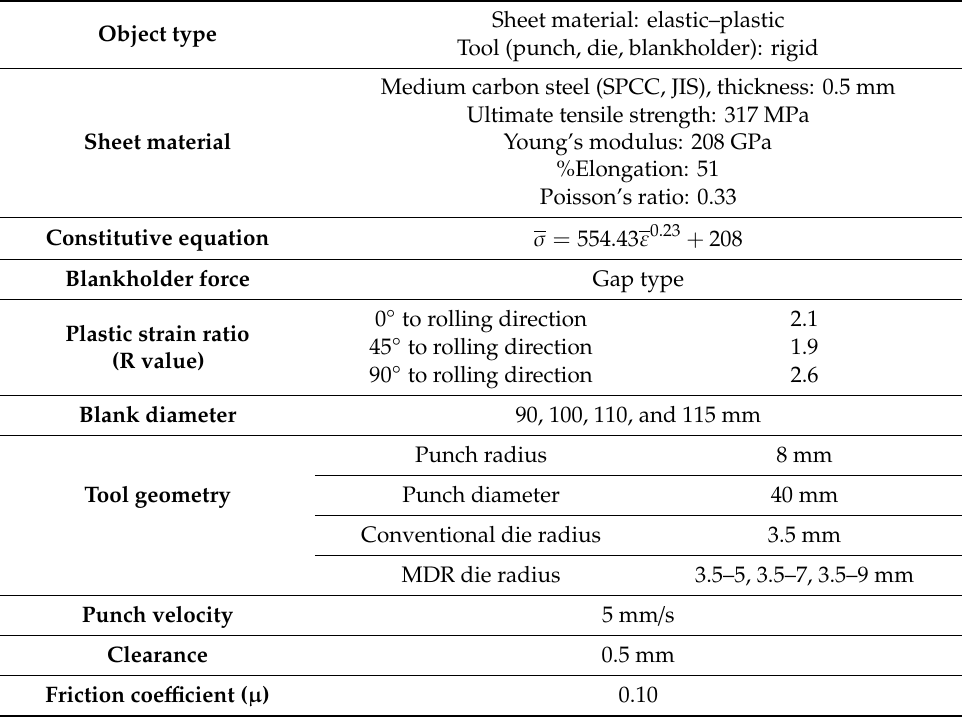
Figure 3. Deep drawing simulation models: ( a ) Conventional deep drawing model; ( b ) Multi draw-radius deep drawing model. Table 1. FEM simulation and experimental conditions.